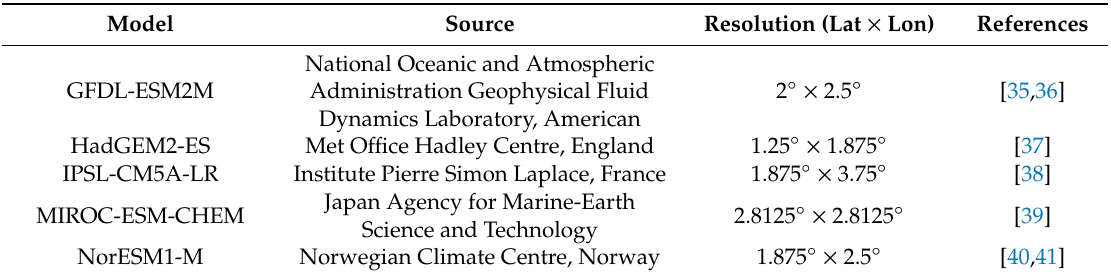
Table 1. Information of five CMIP5 climate